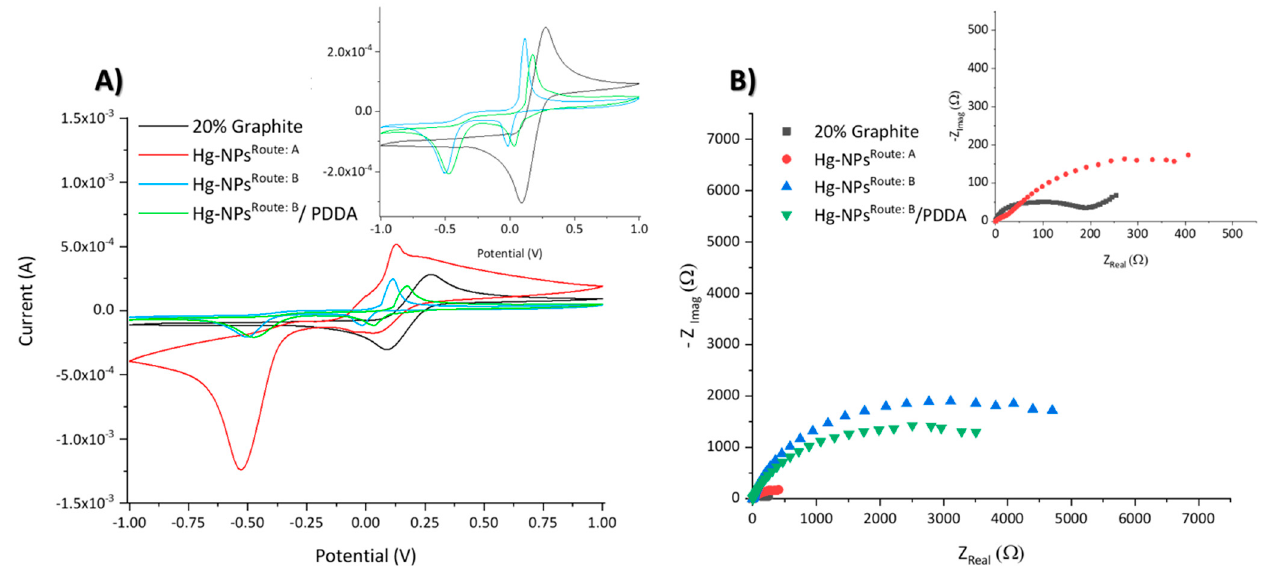
Figure 3. Electrochemical electrode characterization. ( A ) Superposition of the cyclic voltammo- grams obtained for each type of electrode: bare (20% graphite), Hg-NPs Route A , Hg-NPs Route B , Hg- NPs Route B /PDDA. Scan rate: 10 mV·s − 1 . ( B ) Electrochemical impedance spectroscopy obtained for each type of electrode: bare (20% graphite), Hg-NPs Route A , Hg-NPs Route B , Hg-NPs Route B /PDDA.